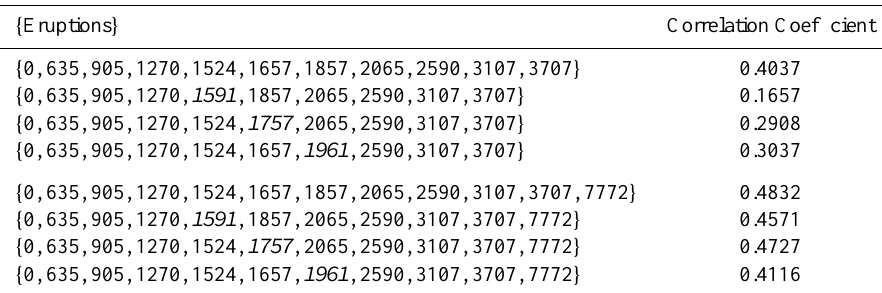
Table 8. Serial correlation coefficients of different sets of eruptions. The sets are formed with different combinations of the average from the 5th to the 8th eruption (Table 1).